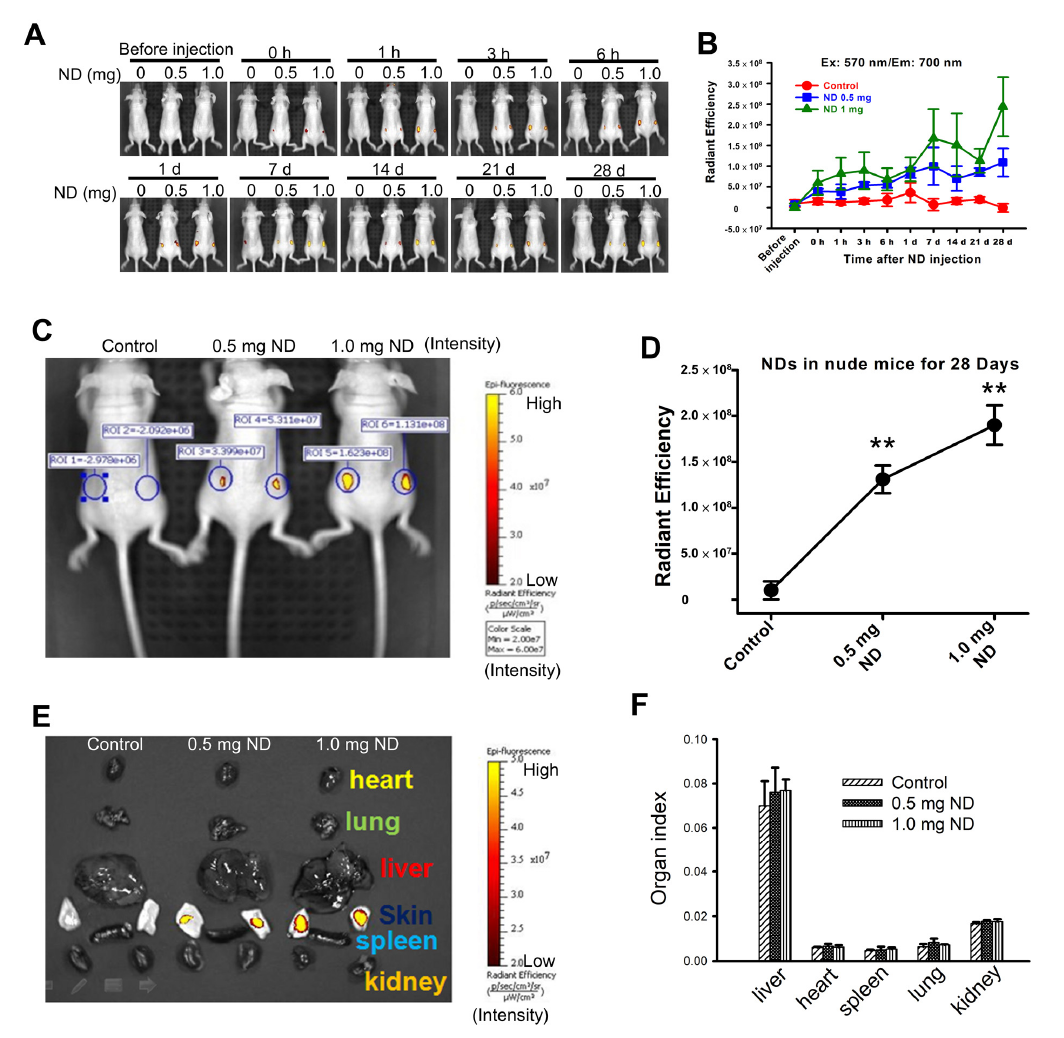
Figure 2. The detection of ND particles in nude mice and organs after 28 days by IVIS system. ( A ) The time-lapse recording of fluorescence intensity of ND particles in nude mice. Fixed wavelength filter in Ex/Em = 570 nm/680 nm and observed the fluorescence signal on different time points by IVIS. Three nude mice for a group, the left mice injected 100 µ L PBS, middle-treated with 0.5 mg ND/100 µ L PBS, and the right mice treated with 1 mg ND/100 µ L PBS. ( B ) The fluorescence intensity of ND − injected nude mice indifferent time point was recorded. The relative fluorescence signal in ROI region was quantified using IVIS software. ( C , D ) Representative images of the whole body and quantitation of fluorescent signal in the region. Results were obtained from three separate experiments and the bar represented the mean ± S.E. ** p < 0.05 indicates significant differences compared to the control group. ( E ) Representative fluorescence image of organ (from top to bottom are heart, lung, liver, skin, kidney, and spleen) and fluorescence intensities of dissected skin. The skin was imaged immediately following dissection and calculated as fluorescence intensity (photons/second (p/s)). ( F ) Comparison of the organ weight of ND particles injected subcutaneous in different concentrations.